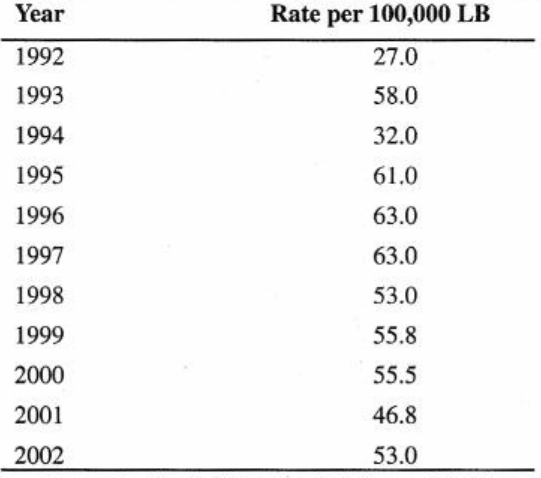
Table 2 - Trends in Maternal Mortality